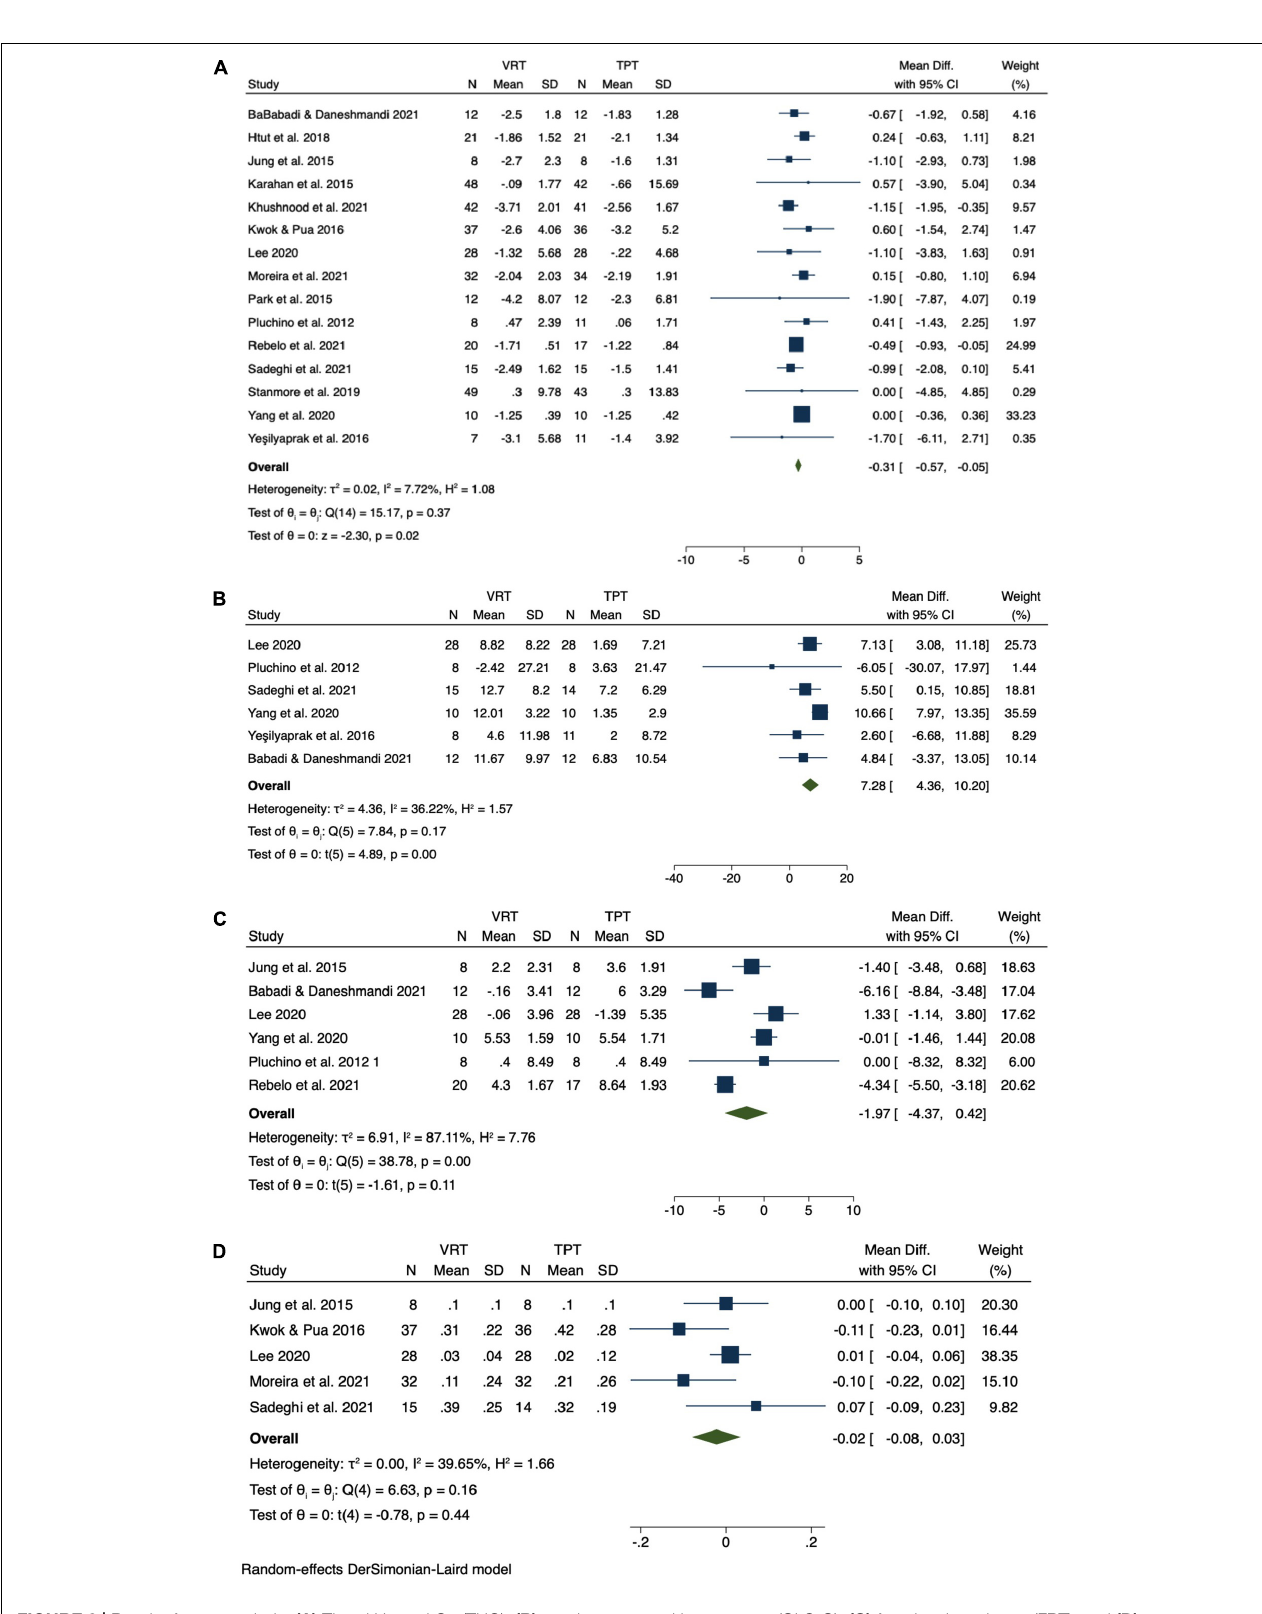
Frontiers in Human Neuroscience |